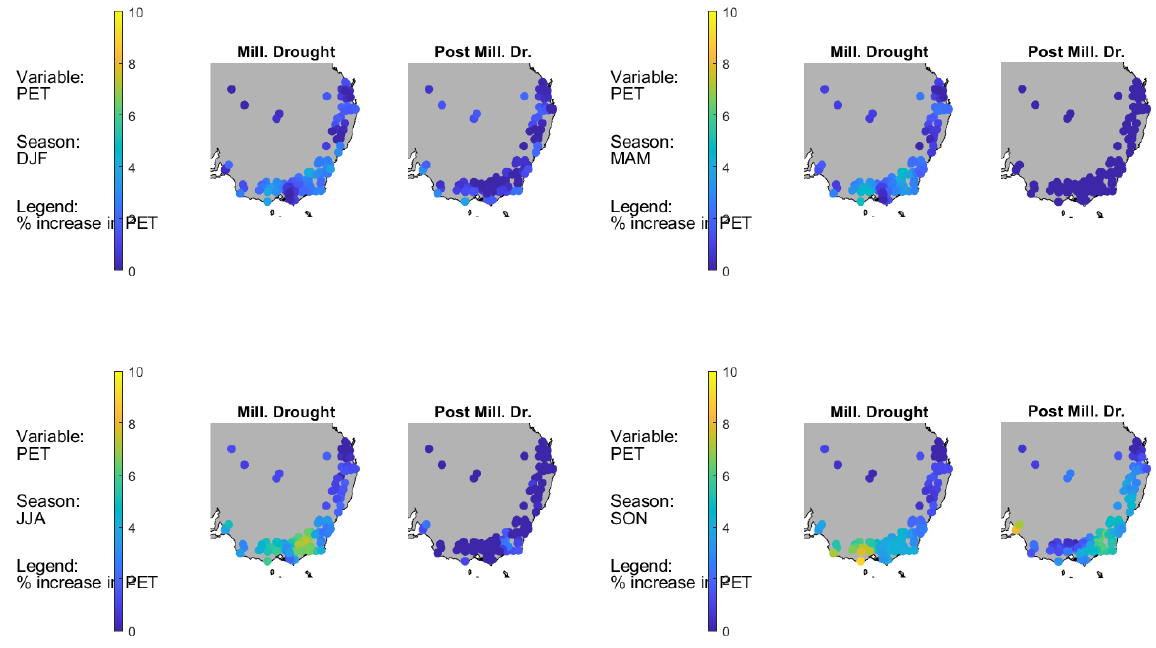
Figure D4. Same as Fig. D1 except for PET (see Fig. 3 for PET definition). Based on data from Fowler et al. (2021).